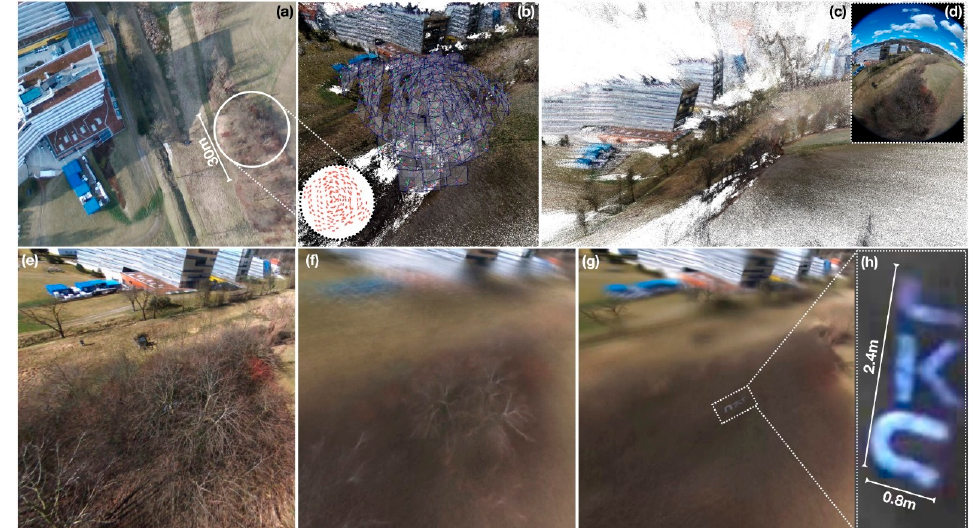
Figure 3. A densely forested patch is captured with a circular synthetic aperture of 30 m diameter ( a ), sampled with 231 video images ( b ) from a camera drone at an altitude of 20 m above ground. A dense 3D point cloud reconstruction from these images ( c ) took 8 h to compute with photogrammetry. ( d ) A single raw video image captured through the narrow-aperture omnidirectional lens of the drone. After image rectification, the large depth of field does not reveal features on the ground that are occluded by the trees ( e ). Increasing the aperture computationally decreases the depth of field and significantly blurs out-of-focus features ( f ). Shifting focus computationally towards the ground slices optically through the tree branches ( f ) makes a hidden ground target visible ( g , h ). Synthetic aperture rendering was possible in real-time after 15 min of preprocessing (image rectification and pose estimation). 3D visualization results are shown in Supplementary Materials Video S1.